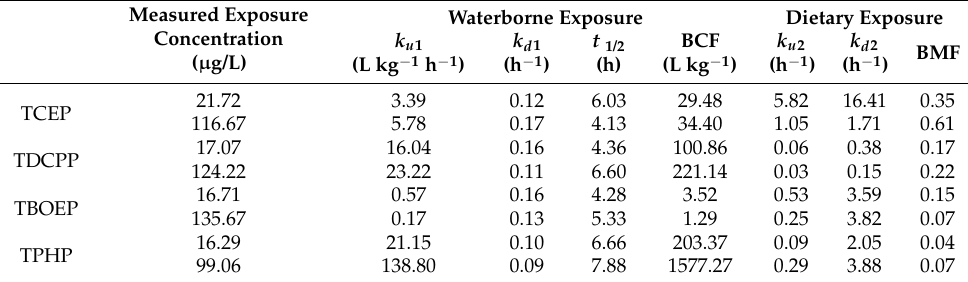
Table 1. Parameters in uptake and depuration kinetics of OPEs in D. magna